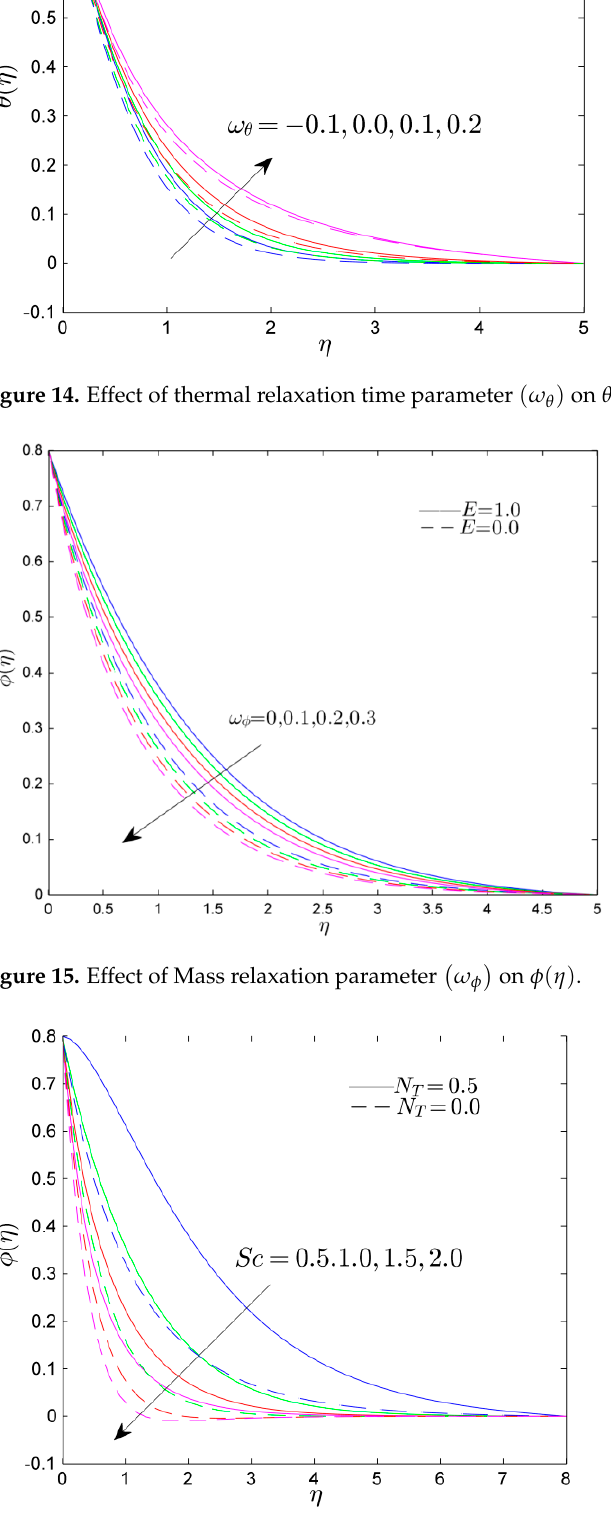
Figure 16. Effect of Schmidt number (𝑆𝑐) on 𝜙(𝜂) .